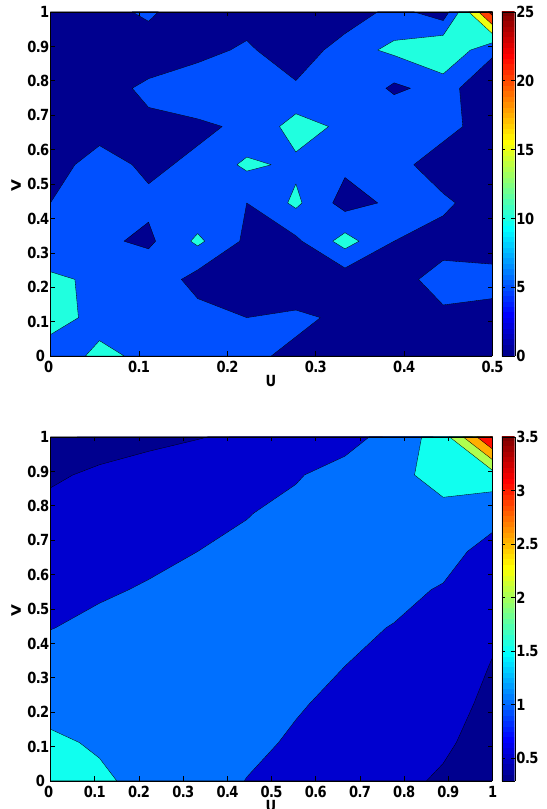
Fig. 5. Probability density function of the empirical copula (top) Fig. 5: Probability density function of the empirical Copula and theoretical Gumbel-Hougaard copula (bottom) for the station (top) and theoretical Gumbel-Hougaard Copula (bottom) for the station Garmisch-Partenkirchen.